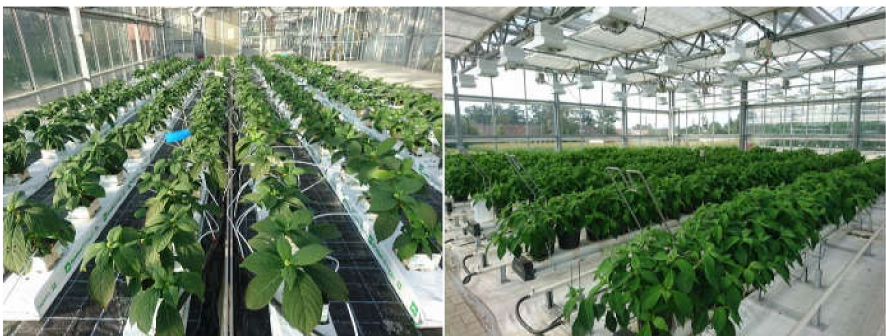
Figure 1. H. macrophylla grown in greenhouses using two different substrates for hydroponic cultiva- tion: rock wool (left ) and perlite ( right